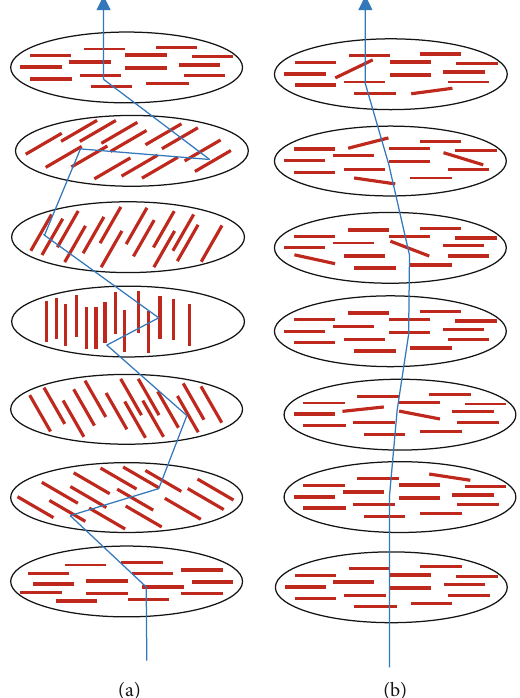
Figure 5: Scheme of the pass of an electrical current through (a) a chiral nematic crystal and (b) a crystal having the same orientation on its layers. For the chiral nematic crystal, an arrangement of a pitch p/2 is shown.